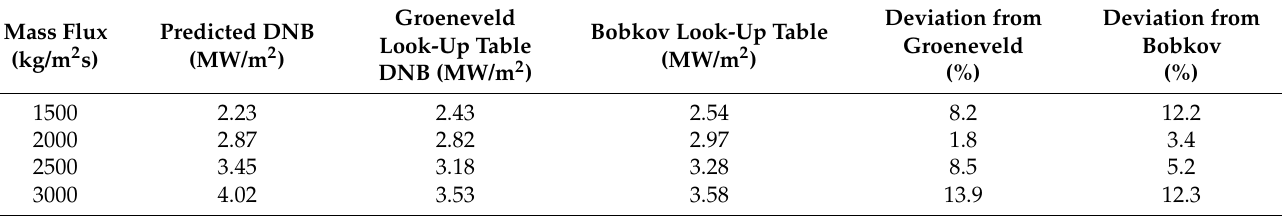
Table 7. Comparison of predicted DNB to Look-up table [1,2]